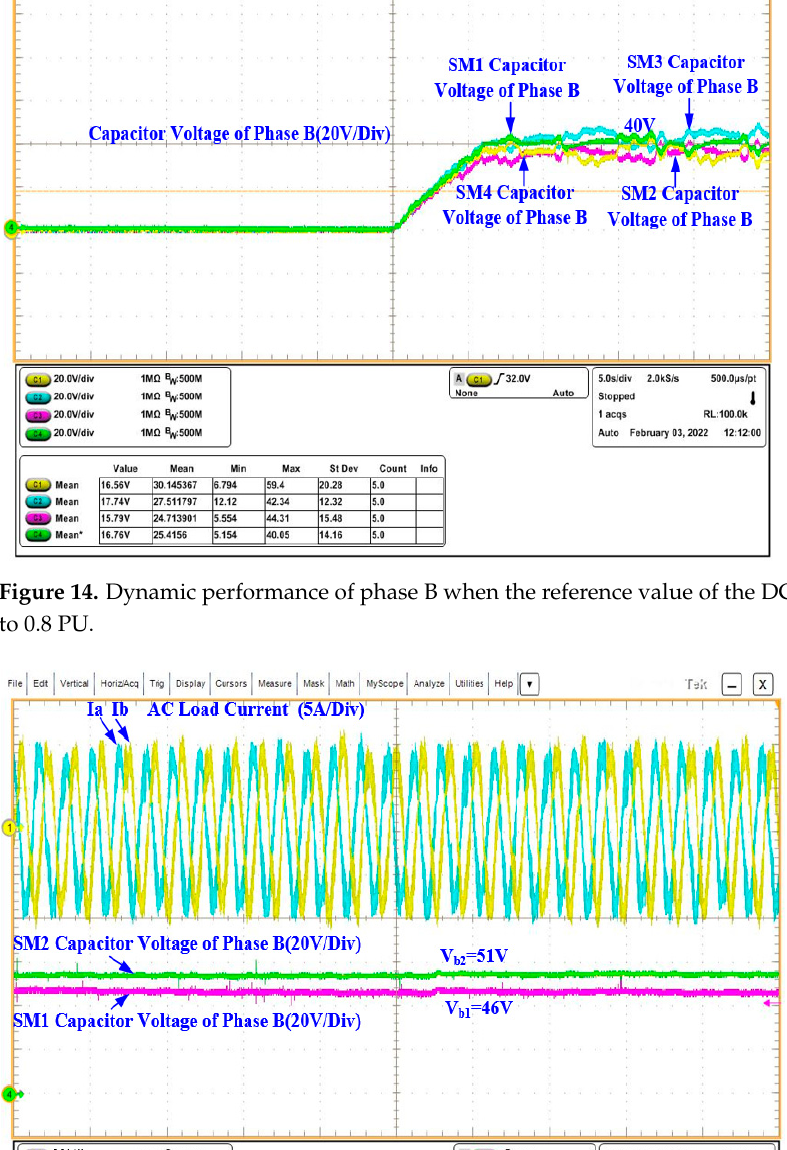
Figure 13. Sensor ( left ) and signal conditioning ( right ) board of the MMC prototype.